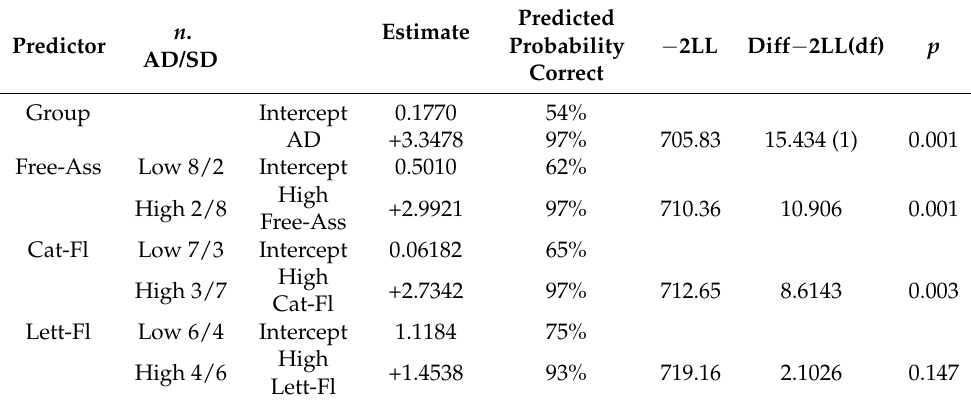
Table 4. Coefficients for mixed effects model contrasting the roles of Group and Diagnostic tasks as unique predictors of accuracy in PN.